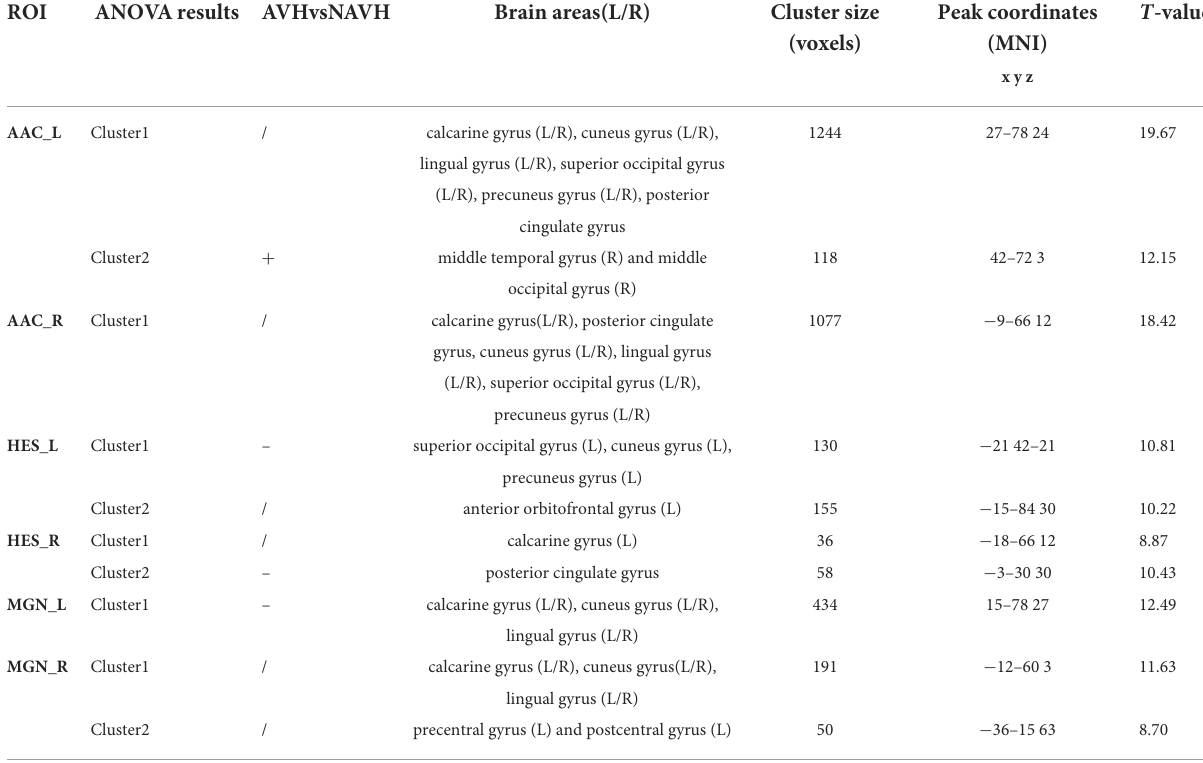
TABLE 2 Whole-brain seed-based dynamic functional connectivity analysis results. ROI ANOVA results AVHvsNAVH Brain areas(L/R) Cluster size